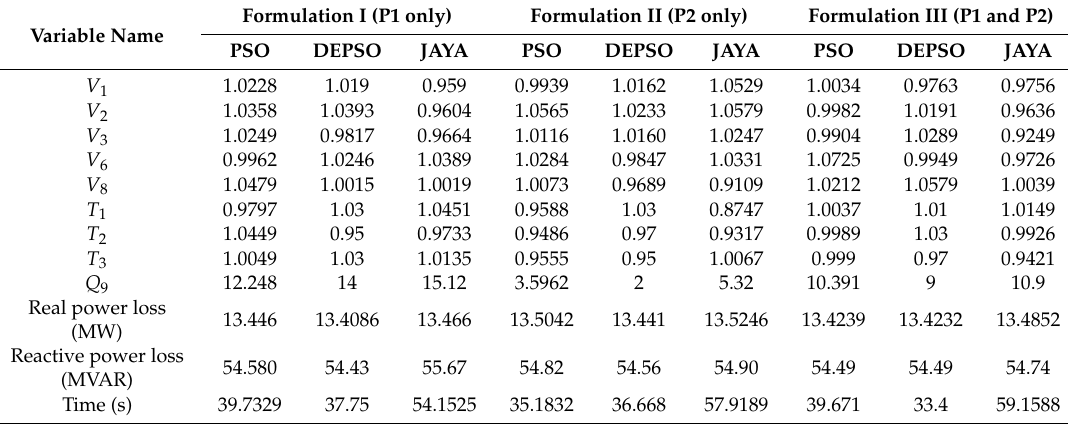
Table 3. Optimal control variables for IEEE 14-bus using di ff erent algorithms.